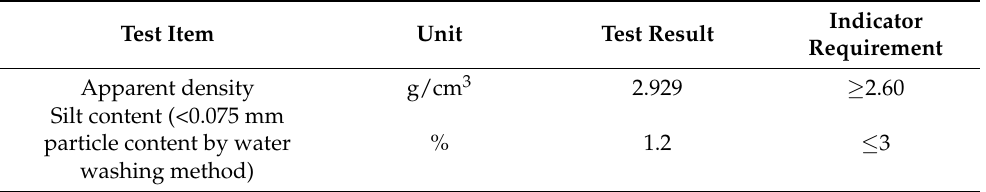
Table 4. Technical indicator requirements and test results of fine aggregate.